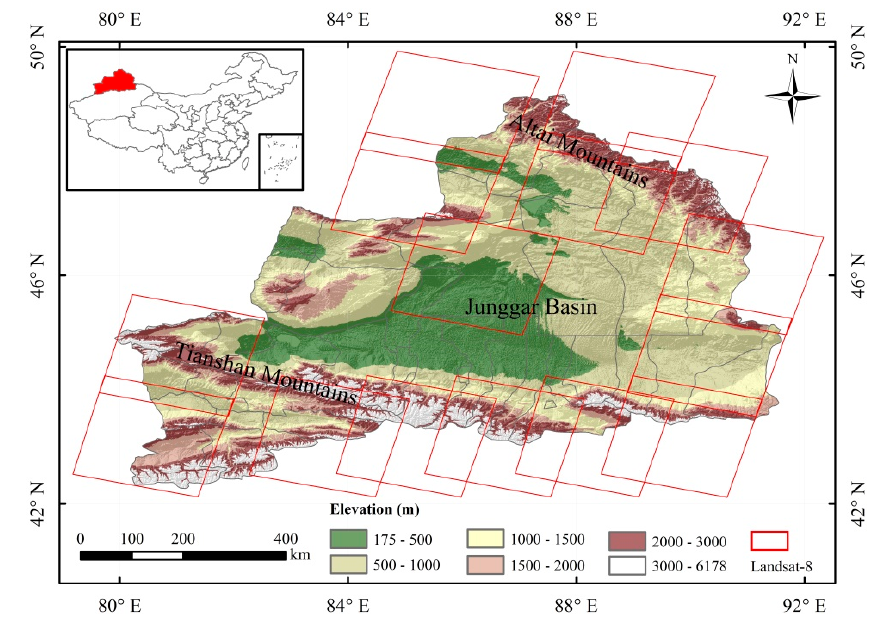
Figure 1. Topographical relief of northern Xinjiang, China.